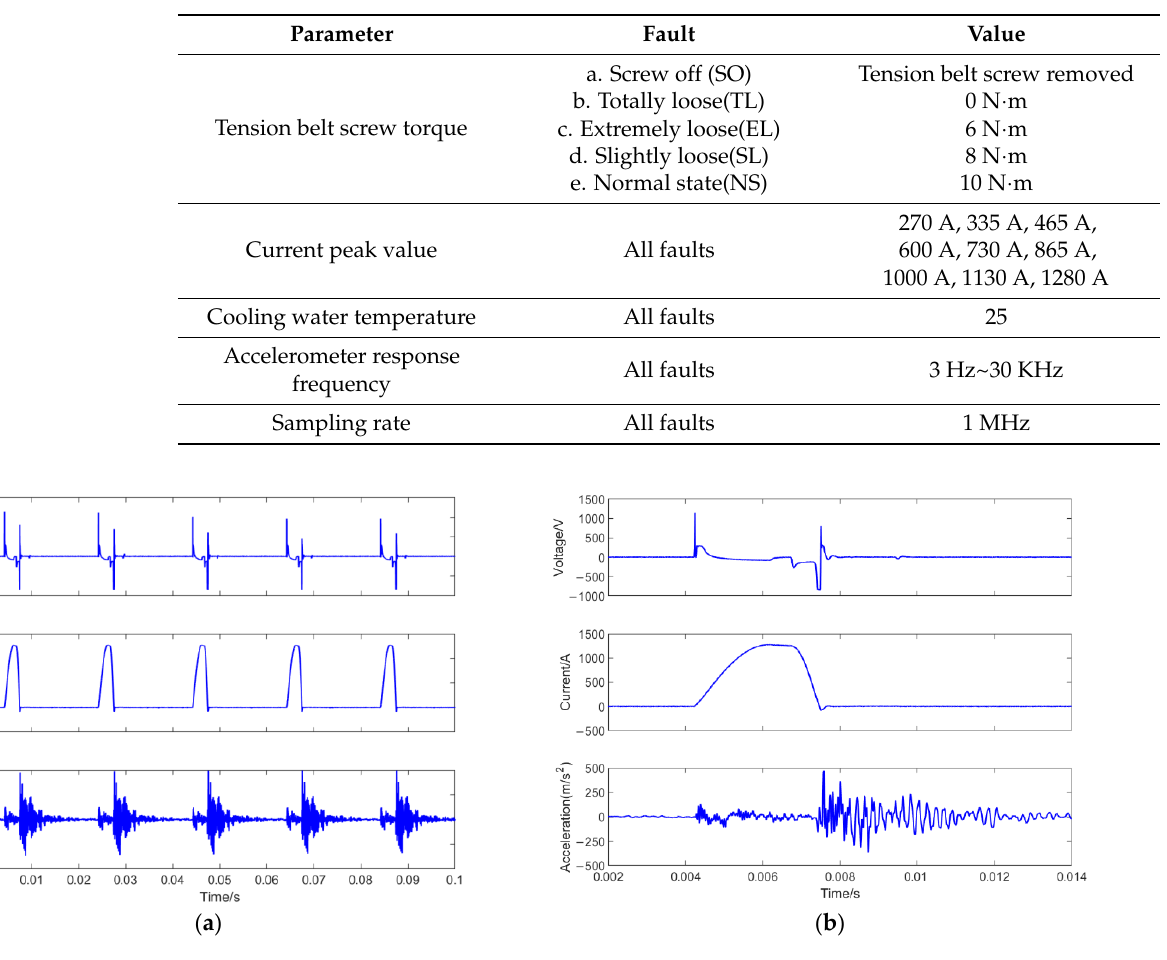
Figure 8. Experimental waveforms of the saturable reactor in the normal state with Ip = 1280 A: ( a ) Time domain waveforms of five consecutive cycles; ( b ) Time domain waveforms of the single valve opening and closing process. Table 4. Parameters of the vibration experiment.